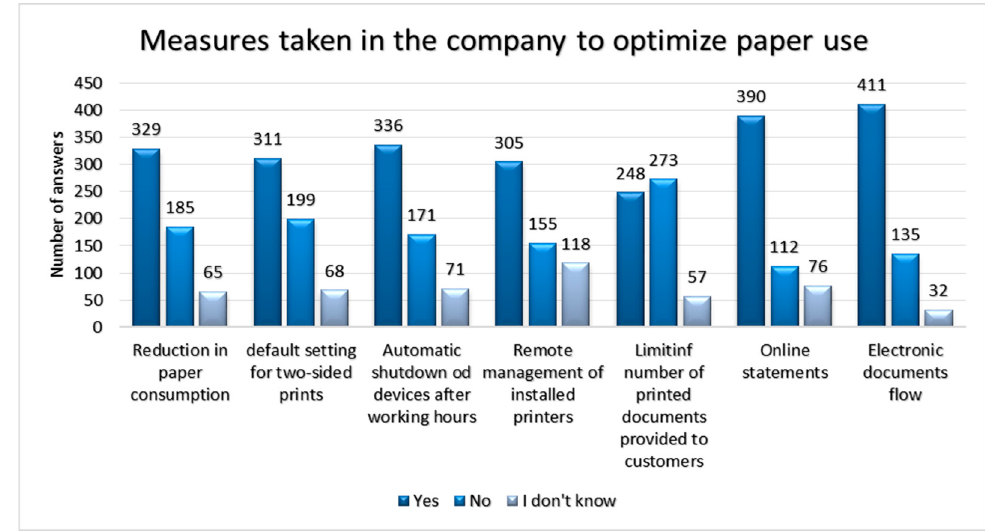
Figure 2. Optimization of the use of paper in the company. Source: Own study based on survey results.